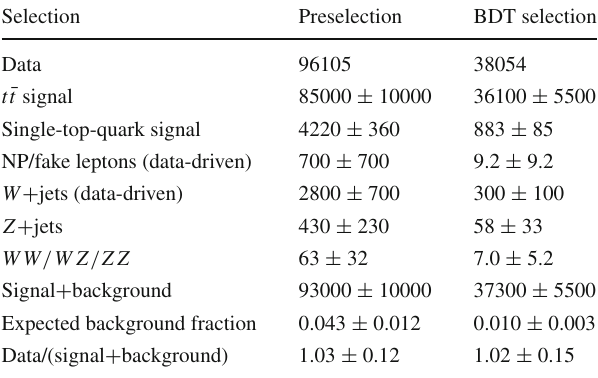
Table 1 The observed numbers of events in data after the event pres- election and the BDT selection (see Sect. 6). In addition, the expected numbers of signal events for m top = 172 . 5 GeV and background events corresponding to the same integrated luminosity as the data are given. Theuncertaintiesinthepredictednumberofeventstakeintoaccountthe statistical and systematic sources explained in Sect. 4.3. Two significant digits are used for the uncertainties in the predicted